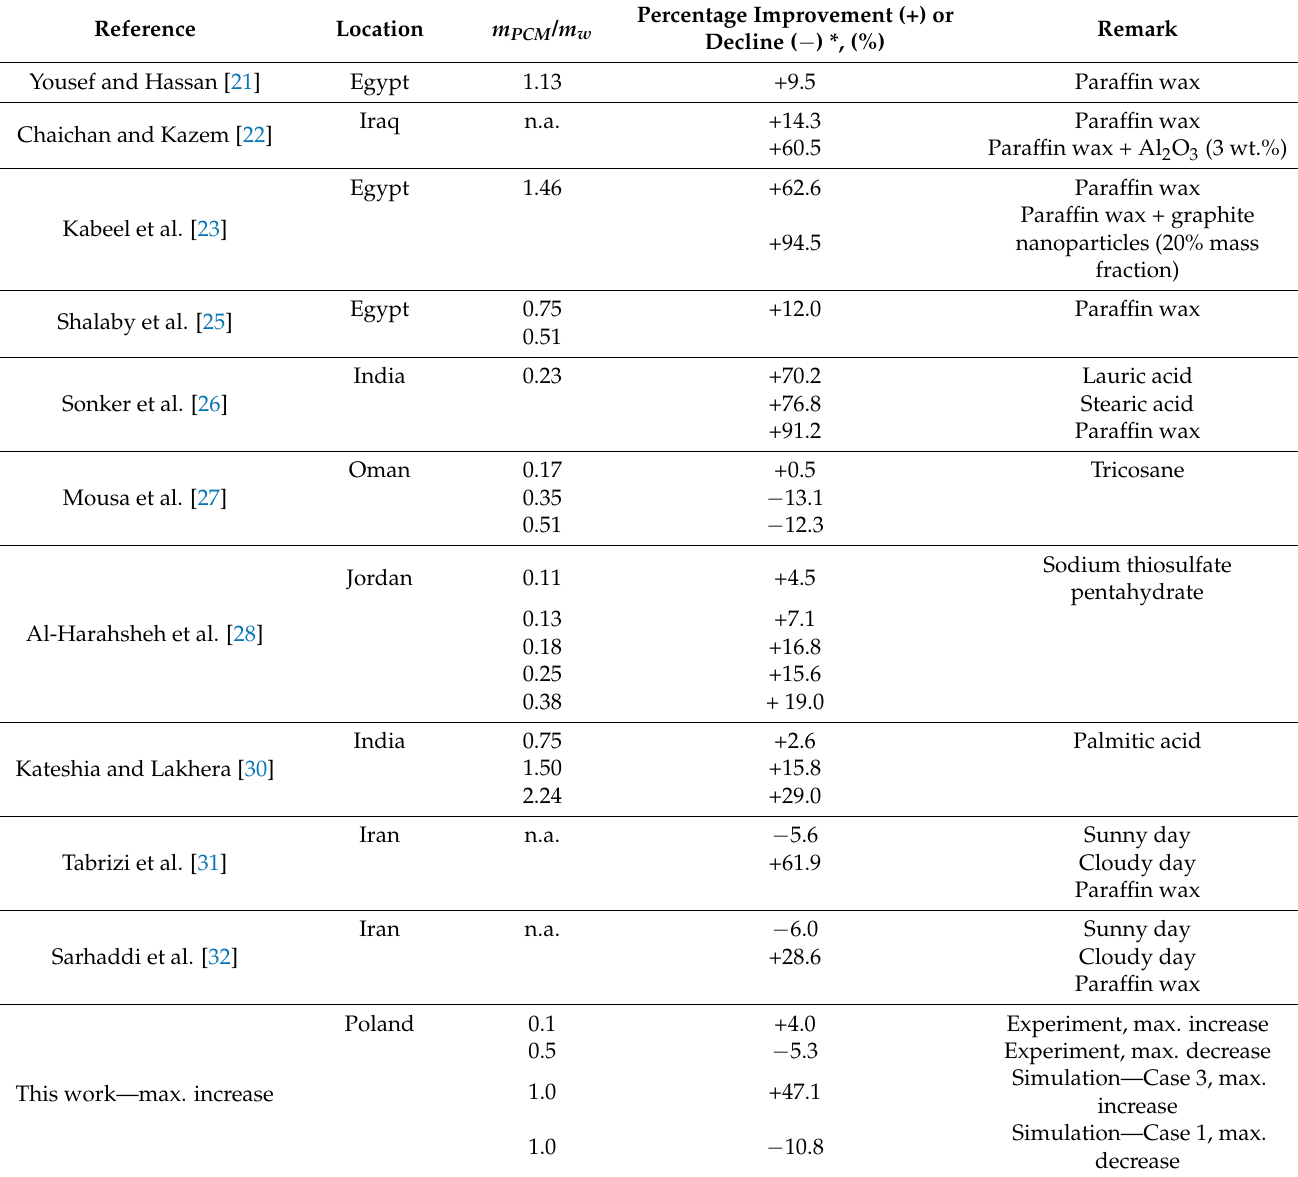
Table 9. Comparison of the